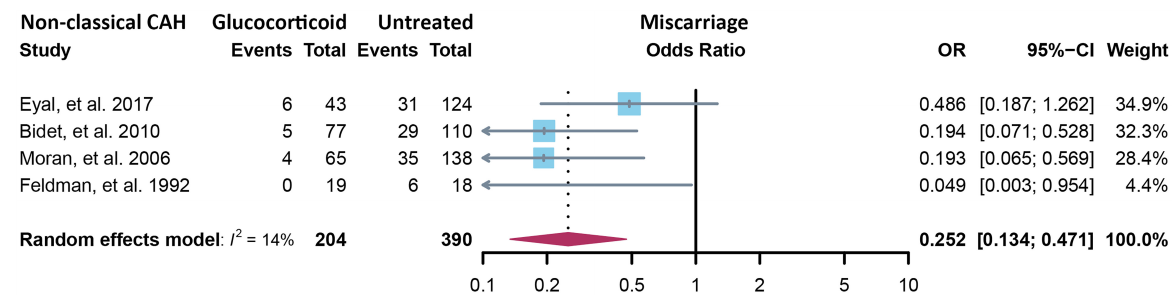
FIGURE 5 Relative risk of miscarriage in the non-classical form of CAH between glucocorticoid treatment and non-treatment. CAH, congenital adrenal